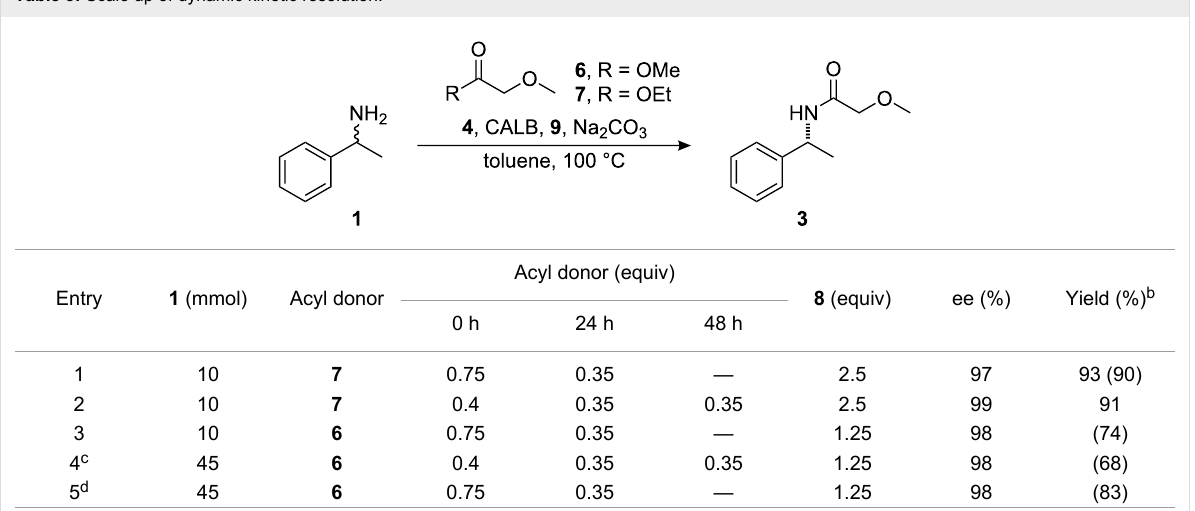
Table 5: Scale up of dynamic kinetic resolution.